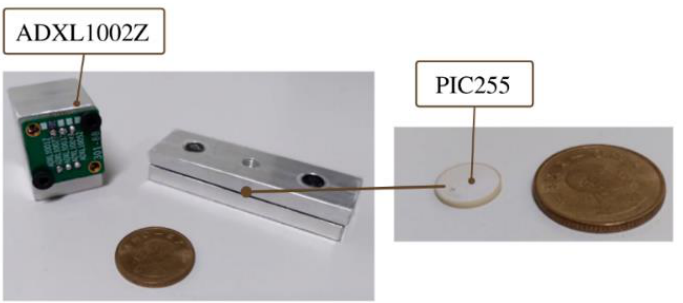
Figure 2. ADXL1002Z MEMS accelerometer and PIC255 piezoelectric disk with their housing sys- tem.